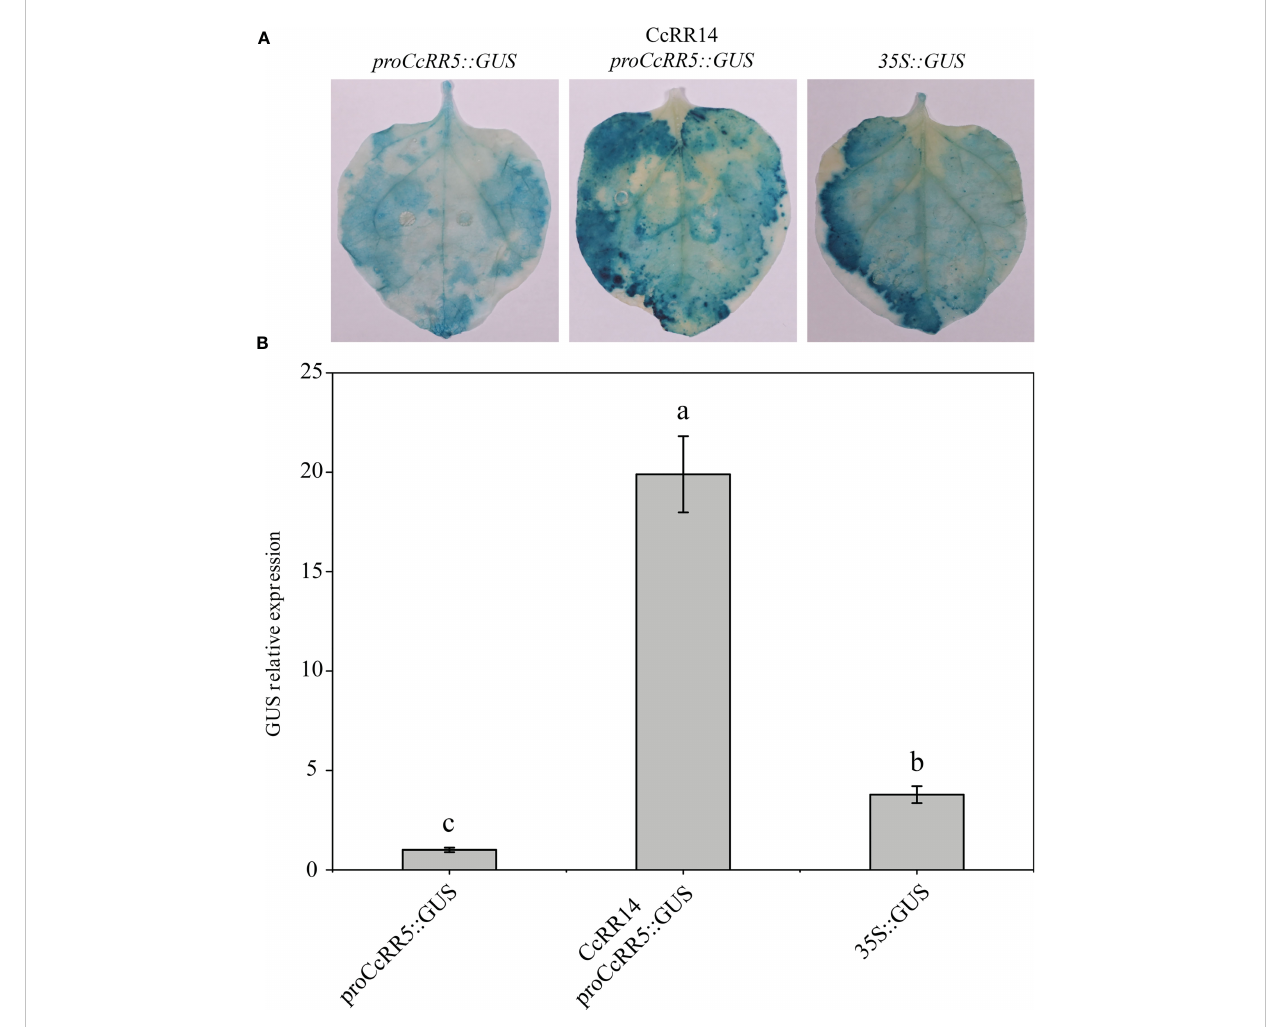
FIGURE 2 Protein – DNA interaction between CcRR14 and the CcRR5 promoter. (A) GUS staining. (B) The expression level of GUS . Each error bar indicated the mean ± SD ( n = 3). Different lowercase letters (a – c) mean signi fi cant difference, p <